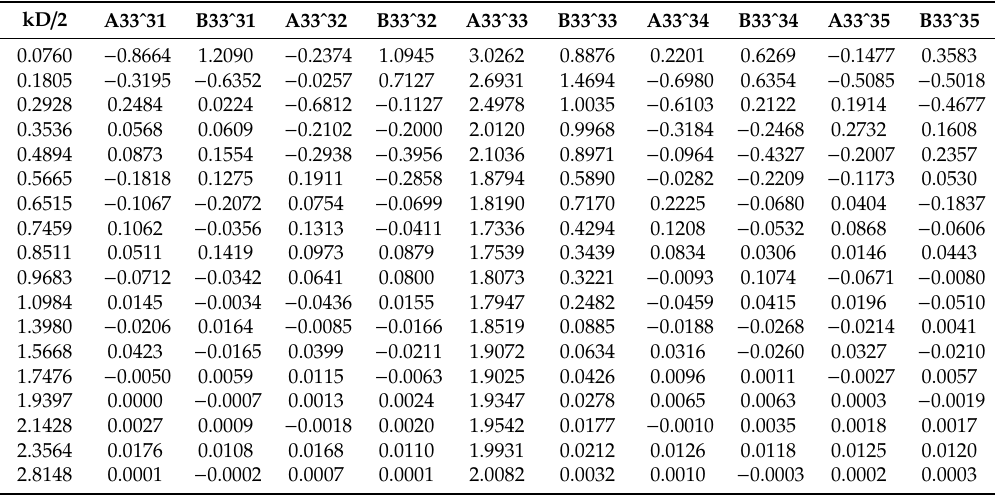
Table A3. Hydrodynamic characteristics of the 3rd floater of the array of five cylindrical